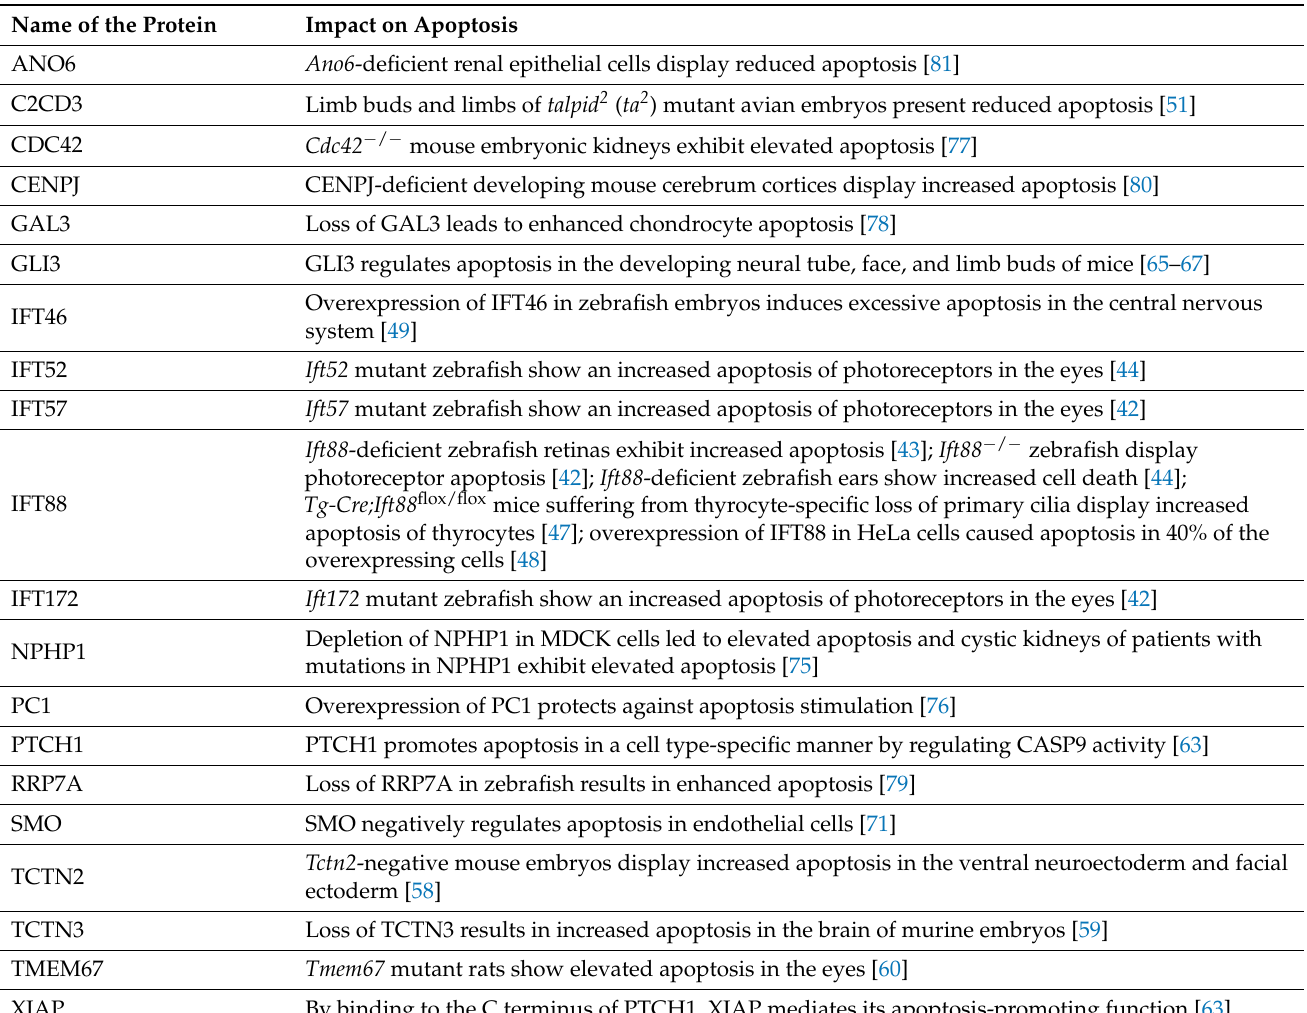
Table 1. Overview of ciliary proteins involved in the regulation of cell